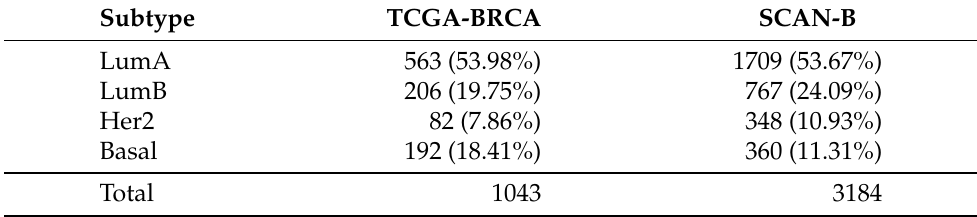
Figure 1. Overview of the genetic algorithm (GA) for patient ordering. ( a ) Chromosome representation. c k indicates the k -th chromosome in the population. g k , i indicates i -th genes in the chromosome. Red colored genes mean that the genes are selected to be related to worse prognosis when its expression is high. Blue colored genes imply that the genes are selected to be associated with a worse prognosis when their expression is low. White colored genes stand for unselected genes. ( b ) Patient ordering from a chromosome. Each patient is characterized by a risk score. Patients are ordered by each selected gene expressed as a ternary representation. For genes related to worse prognosis when its expression level is high, the lower the patient’s expression level, the higher the rank is given (green box). On the contrary, for genes associated with a worse prognosis when its expression quantity is low, the higher the patient’s expression level, the lower the rank is given (violet box). Then, the ranks are averaged for each patient, and it is considered a risk score. Finally, the patients are ordered by the score. ( c ) The stratification score is calculated as Kendall’s tau-b correlation between the vector of subtype corresponding to ordered patients ( s c ), and the vector stratified completely according to subtype order ( s ref ). ( d ) The survival score is computed by analyzing the survival of the groups divided within each subtype. Groups within each subtype are defined through logistic regression with risk score as a variable. Table 2. The number of samples for each subtype of breast cancer data. Values in parentheses mean the proportion of each subtype in the data